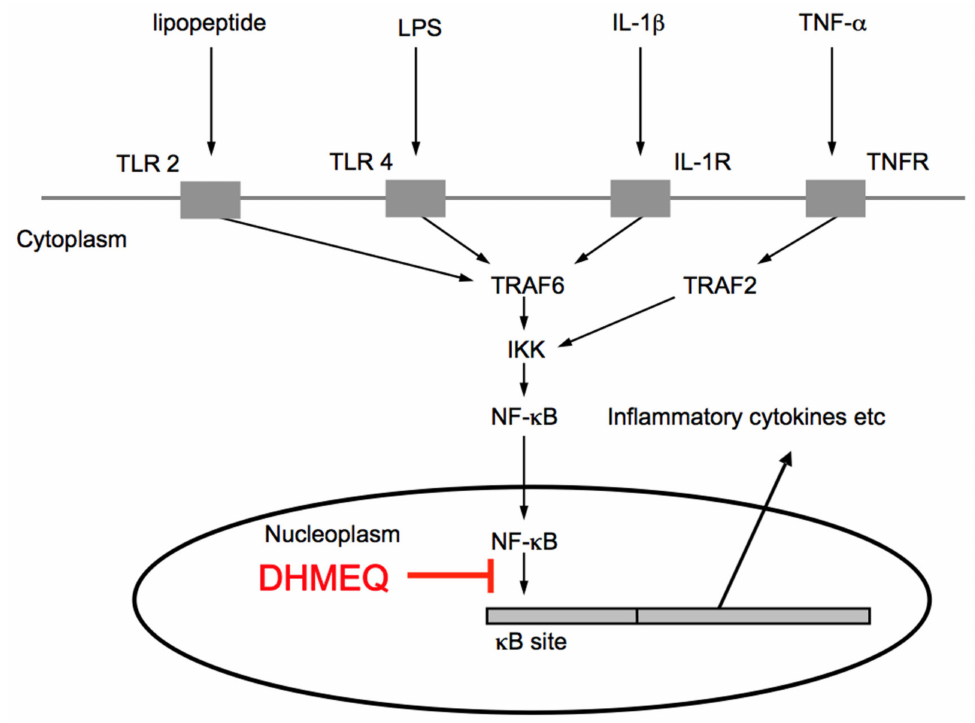
Figure 3. Signaling pathway for NF- κ B activation and inhibition by